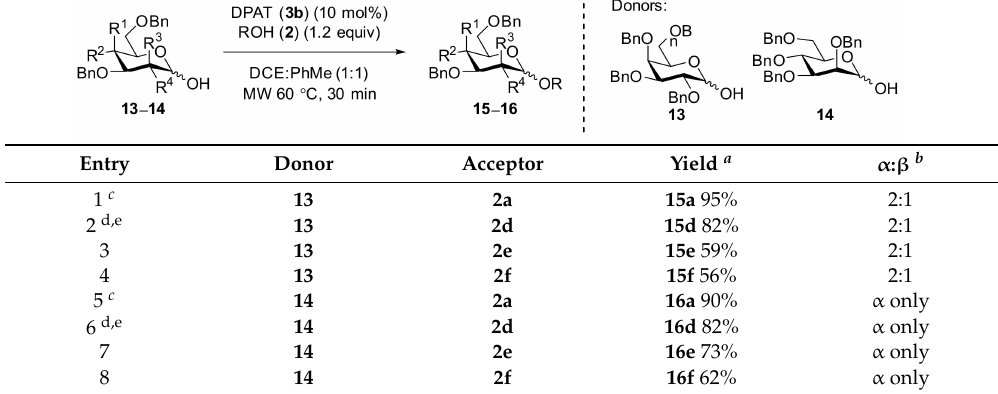
Table 4. Reaction scope of diphenylammonium triflate (DPAT)-catalyzed dehydrative glycosylation of galactose and mannose.